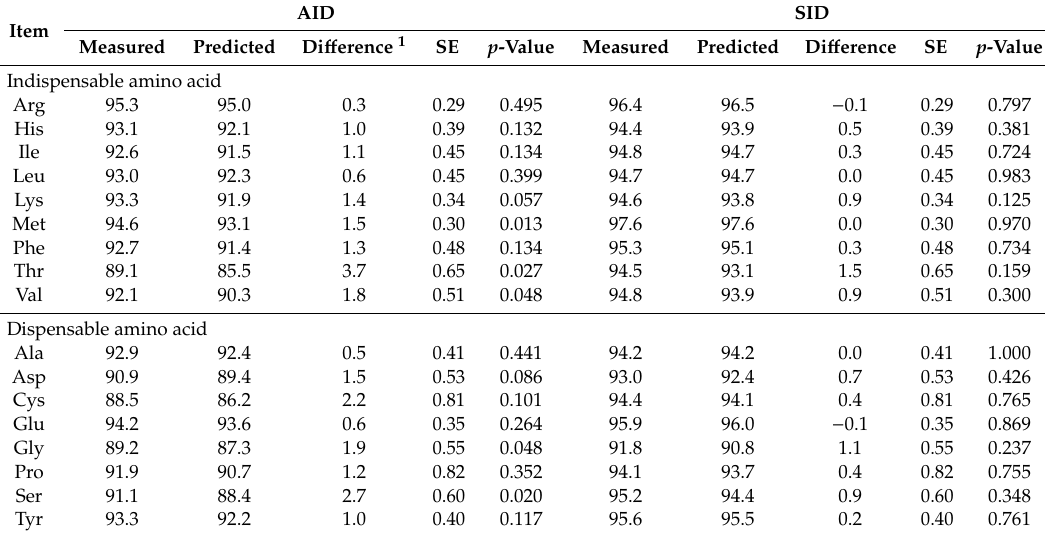
Table 8. Measured and predicted values for AID and SID (%) of AAs and the di ff erence between the measured and the predicted AID and SID of AAs in male broilers fed a corn and SBM mixed